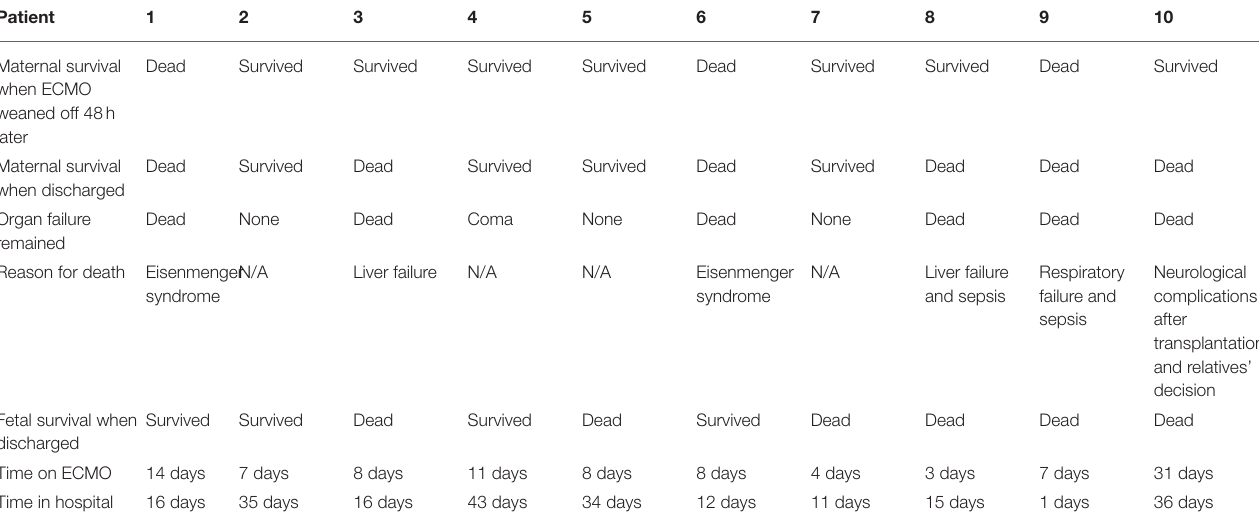
TABLE 4 | Outcomes of ECMO and prognosis of patients. Patient Maternal survival when